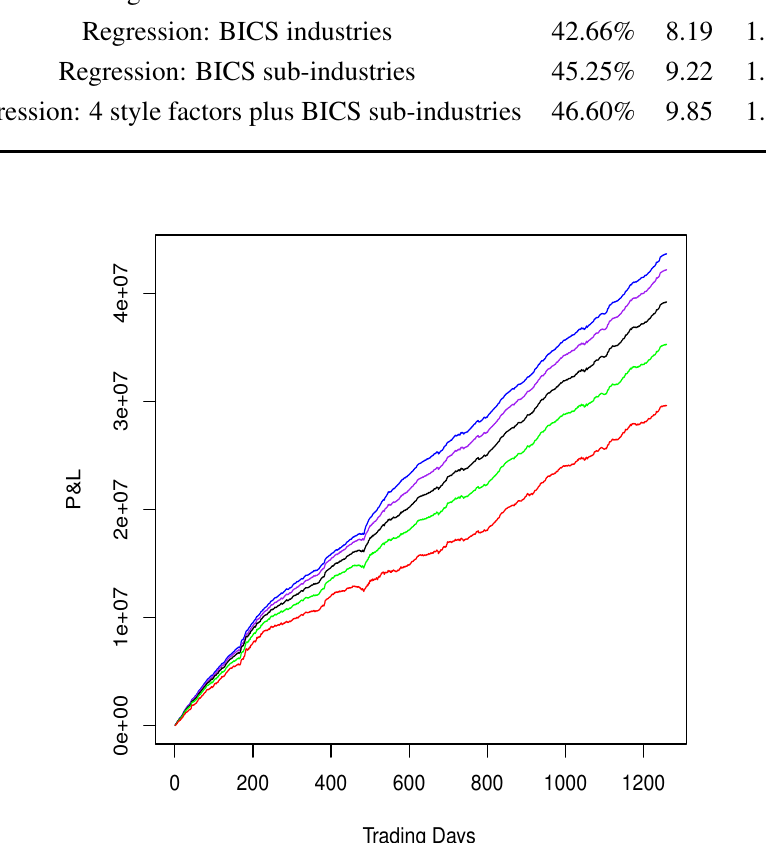
Figure 1. P&L graphs for the intraday alphas discussed in Section 2.5.3, with a summary in Table 2. Bottom-to-top-performing: (i) regression over intercept only; (ii) regression over BICS sectors; (iii) regression over BICS industries; (iv) regression over BICS sub-industries; and (v) regression over the four style factors, prc, mom, hlvand vol, of [60] plus BICS sub-industries. The investment level is $10 M long plus $10 M